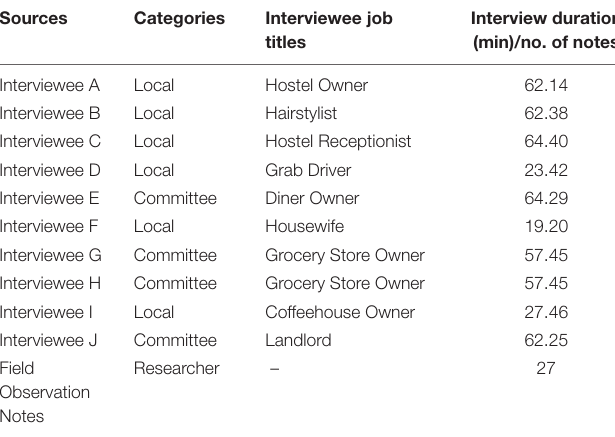
TABLE 2 | Participant information, interview time duration, and field observation